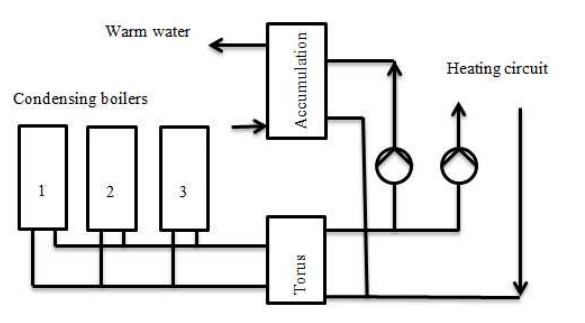
Fig.1. Simplified scheme of engagemet from the year